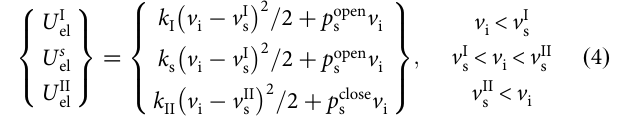
RT Þ = g (cid:2)(cid:2)! ¼